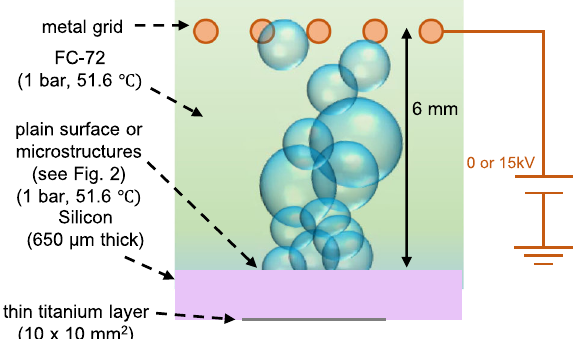
Fig. 2 Sketch of the boiling experiment. The conceptual outline of the experiment, consisting of pool boiling in FC-72 fl uid that takes place on a heated silicon substrate within an electric fi eld produced by the metal